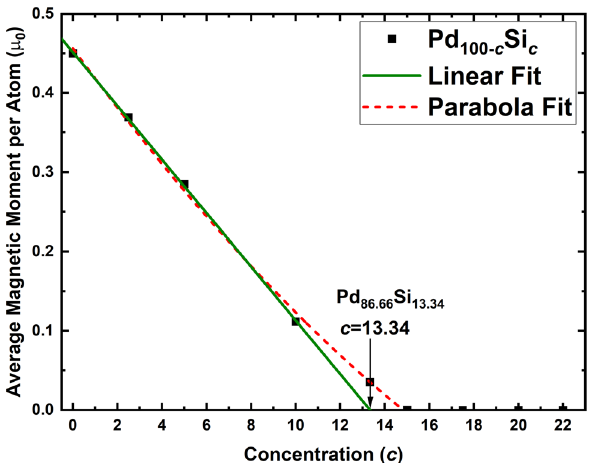
Figure 6. Average magnetic moment, AMM, per atom after the GO runs. The alloy a -Pd 86.66 Si 13.34 was studied to investigate a possible linear fit to our magnetic results. The fit is not linear, green line, it is quadratic, red broken line. See text.